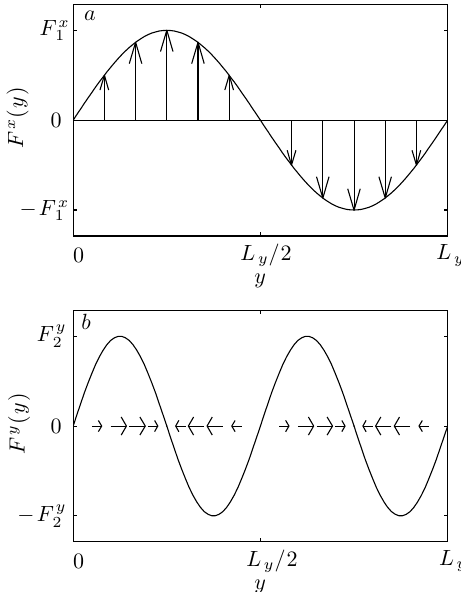
Figure 6. Schematic representation of: the sinusoidal transverse force (STF) ( a ); and the sinusoidal longitudinal force (SLF) ( b ) fields. The arrows show the direction of the forces. The length of the arrows, as well as the sinusoidal line, indicate the strength of the force. The STF is shown for F x ( y ) = F x and the SLF is shown for F y ( y ) = F y sin ( k 2 y ) . Reprinted figure with permission from Glavatskiy, K.S.; 2 Dalton, B.A.; Daivis, P.J.; Todd, B.D., Phys. Rev. E 91 , 062132 (2015). Copyright (2015) by the American Physical Society